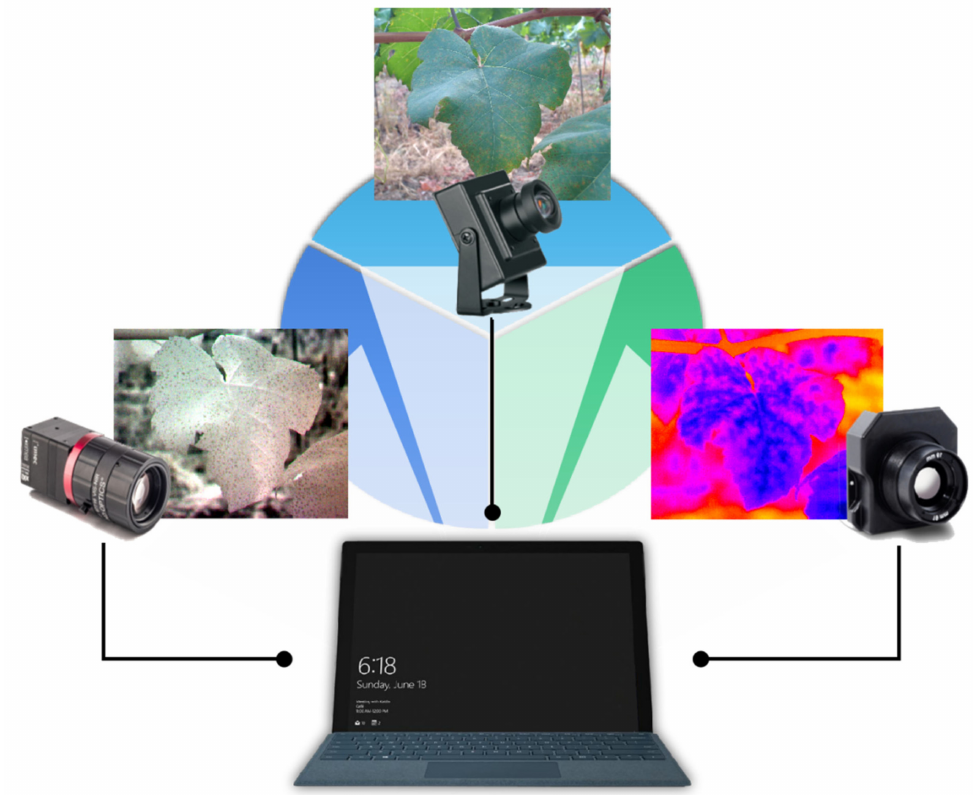
Figure 1. Image collection. Multispectral (MS), RGB, and thermal infrared (TIR) cameras are connected to a portable computer through data lines. Additionally, the multispectral image (MSI), RGB image (RGBI), and thermal infrared image (TIRI) were collected by corresponding cameras controlled by the computer. Table 1. Details of six classes of grape foliage diseases and pests in the image set. “HZ” refers